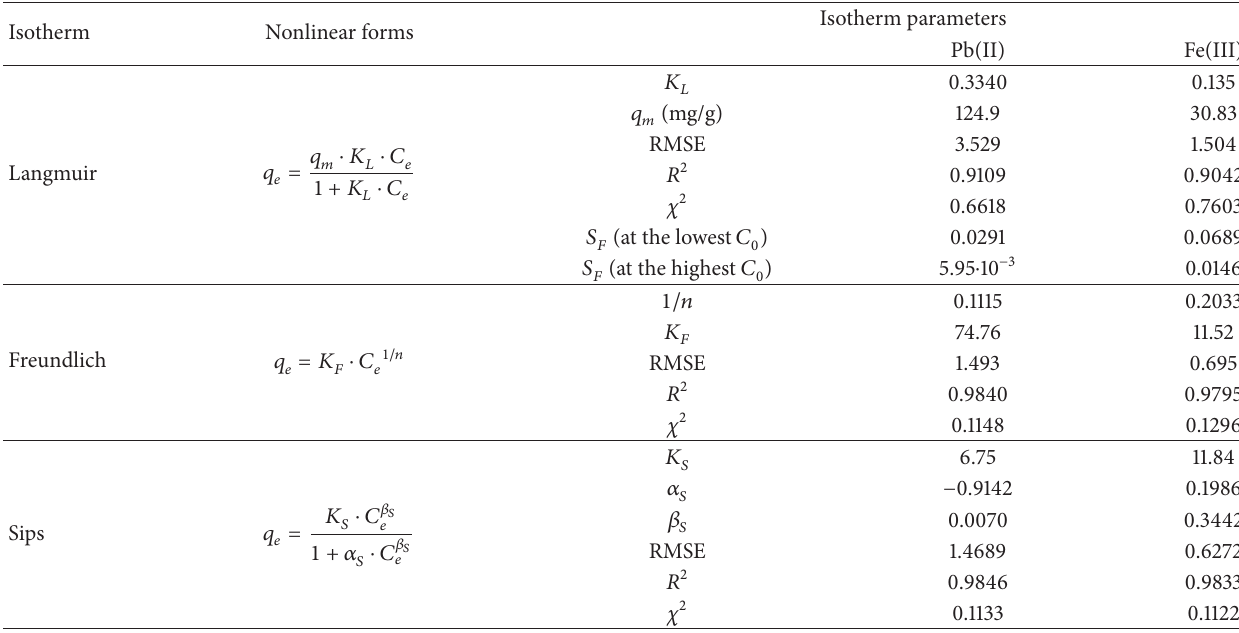
Table 2: Equilibrium isotherm